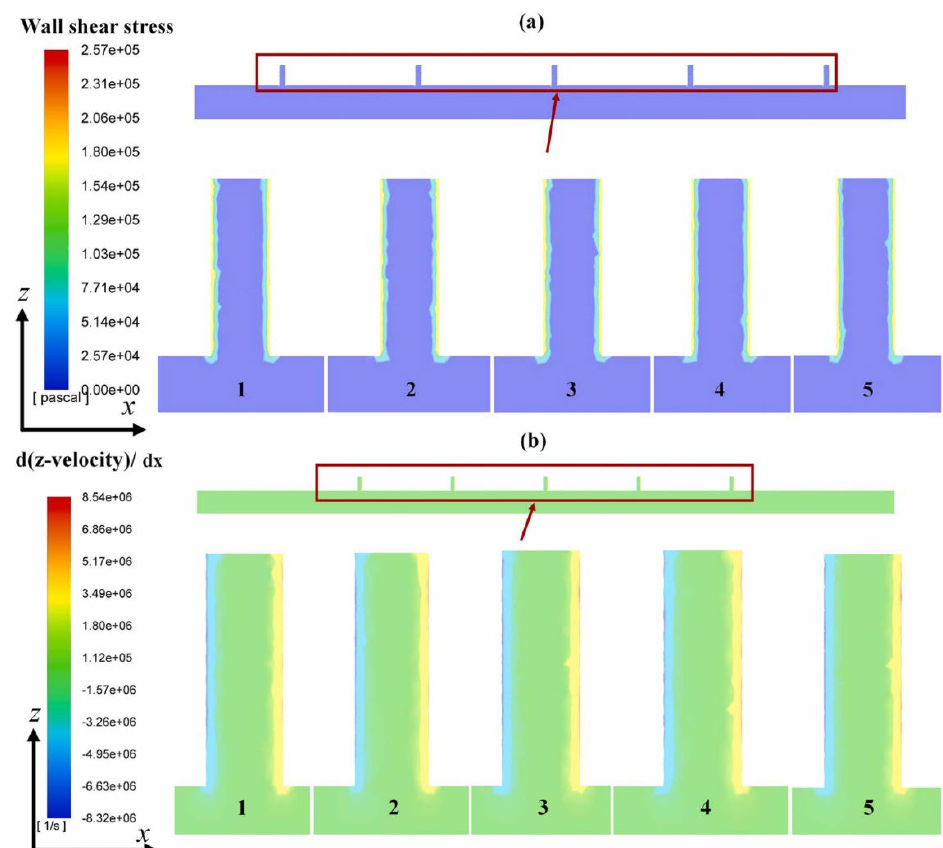
Figure 19. CFD simulation results of ( a ) wall shear stress and ( b ) change rate of the flow velocity along z direction (axial direction) relative to x direction (radial direction) [132].